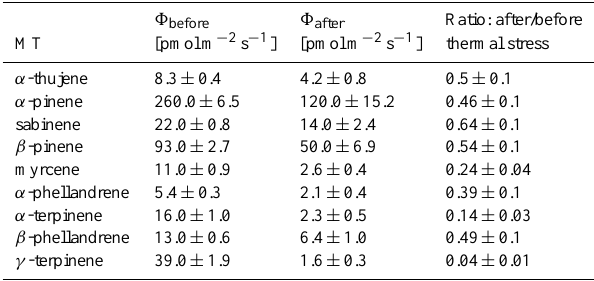
Table 2. Monoterpene emissions from Q. calliprinos measured at a temperature of 24 ◦ C and a PPFD of 800µmolm − 2 s − 1 before and after a heat application. Emission rates are the mean of at least six measurements, and the error limits represent the 1 σ standard